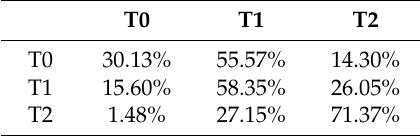
Table 7. PLS predictions for the propranolol set. Confusion matrix for time point prediction. T0 T1